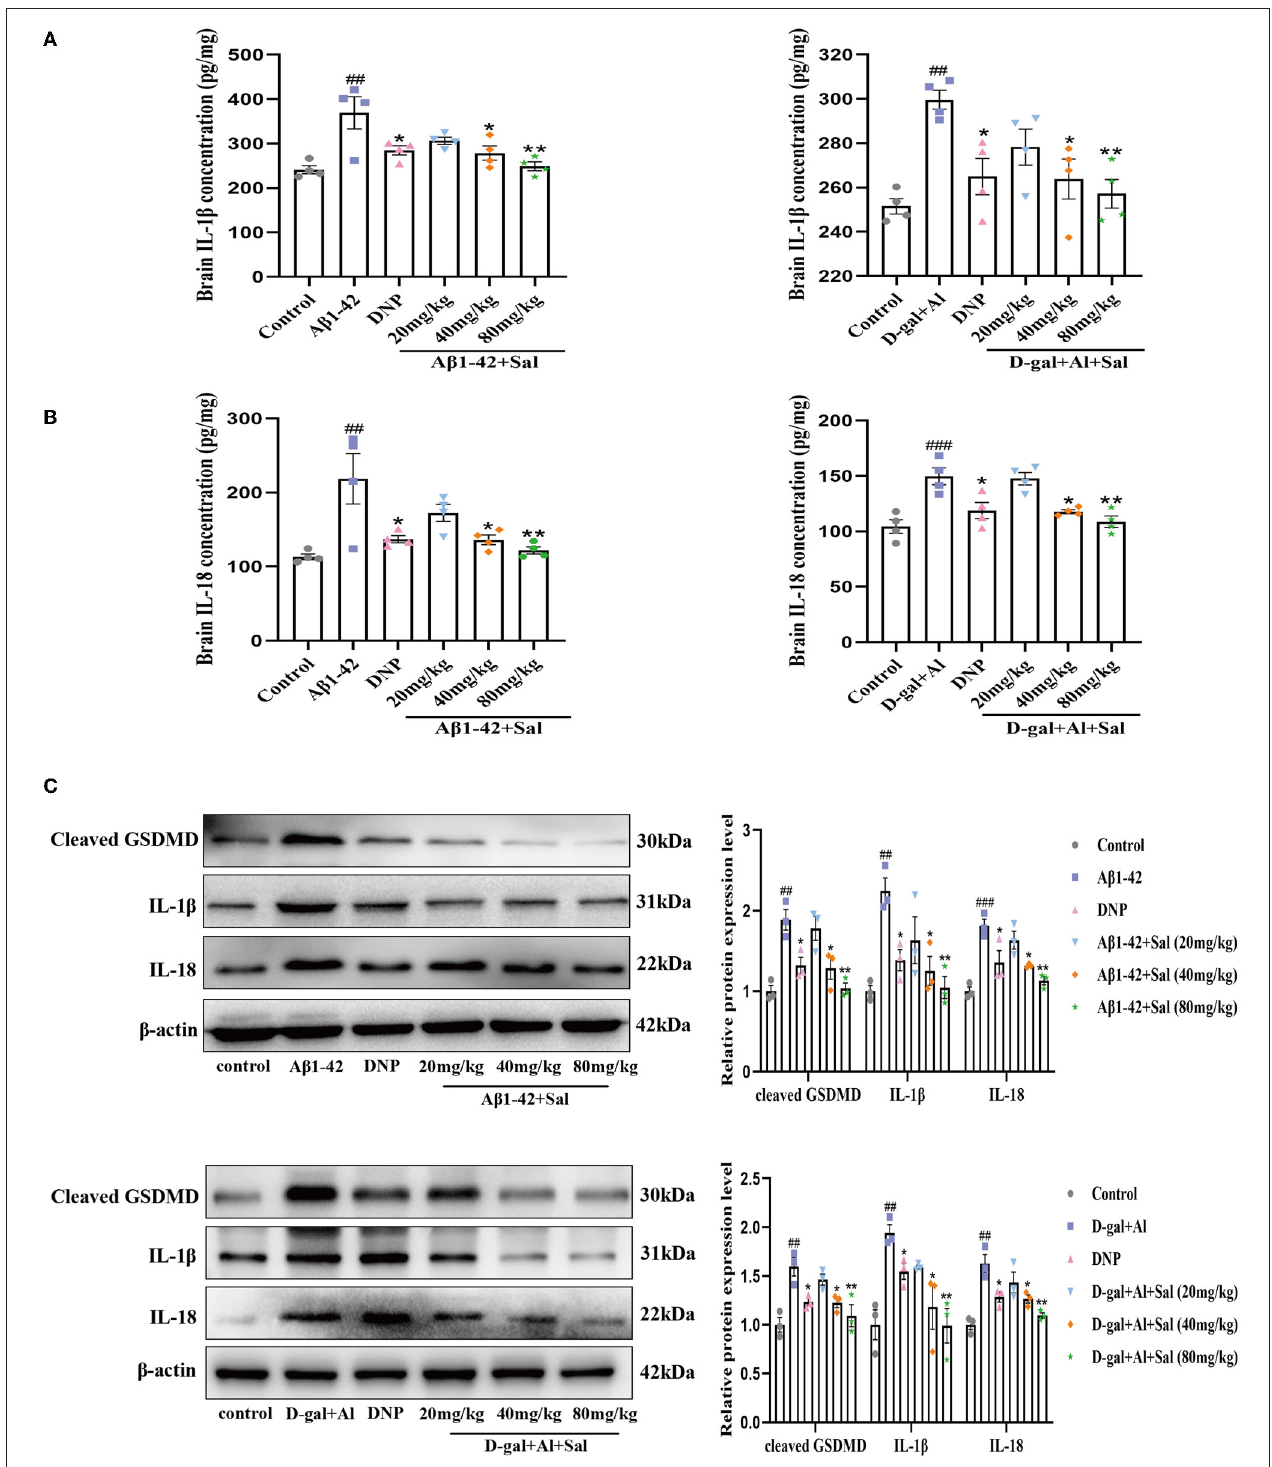
FIGURE 6 | Sal mitigated pyroptosis in A β 1-42 and D-gal/AlCl 3 -induced AD mice. A β 1-42 and D-gal/AlCl 3 -induced AD mice brain expression of IL-1 β (A) and IL-18 (B) analyzed by enzyme-linked immunosorbent assay (ELISA) kits ( n = 4). (C) The Western blot analysis of IL-1 β , IL-18, and cleaved GSDMD in the hippocampus of the AD mice ( n = 3). Image J was applied to quantify the bands, and a histogram represents the differences after normalization to β -actin. All data are represented as mean ± SEM. ## P < 0.01, ### P < 0.001 vs. control group, * P < 0.05, ** P < 0.01, vs. A β 1-42 and D-gal/AlCl 3 group.